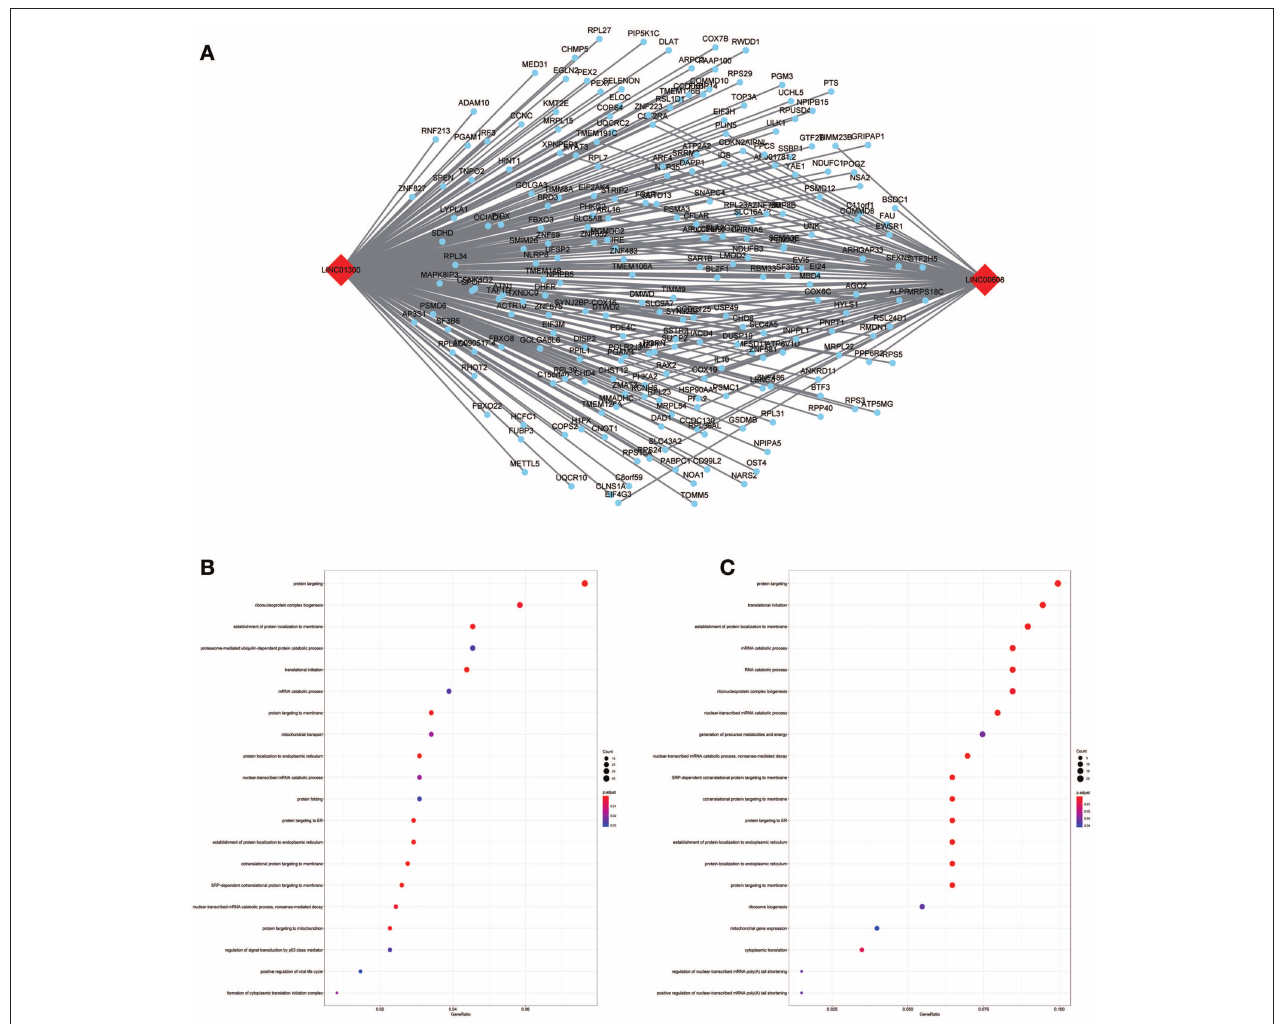
FIGURE 7 | LncRNA-mRNA network in Blue module and functional enrichment. (A) The lncRNA-mRNA network in Blue module, (B) GO-BP enrichment analysis (All genes in Blue module), (C) GO-BP enrichment analysis (LINC01300 related genes in Blue